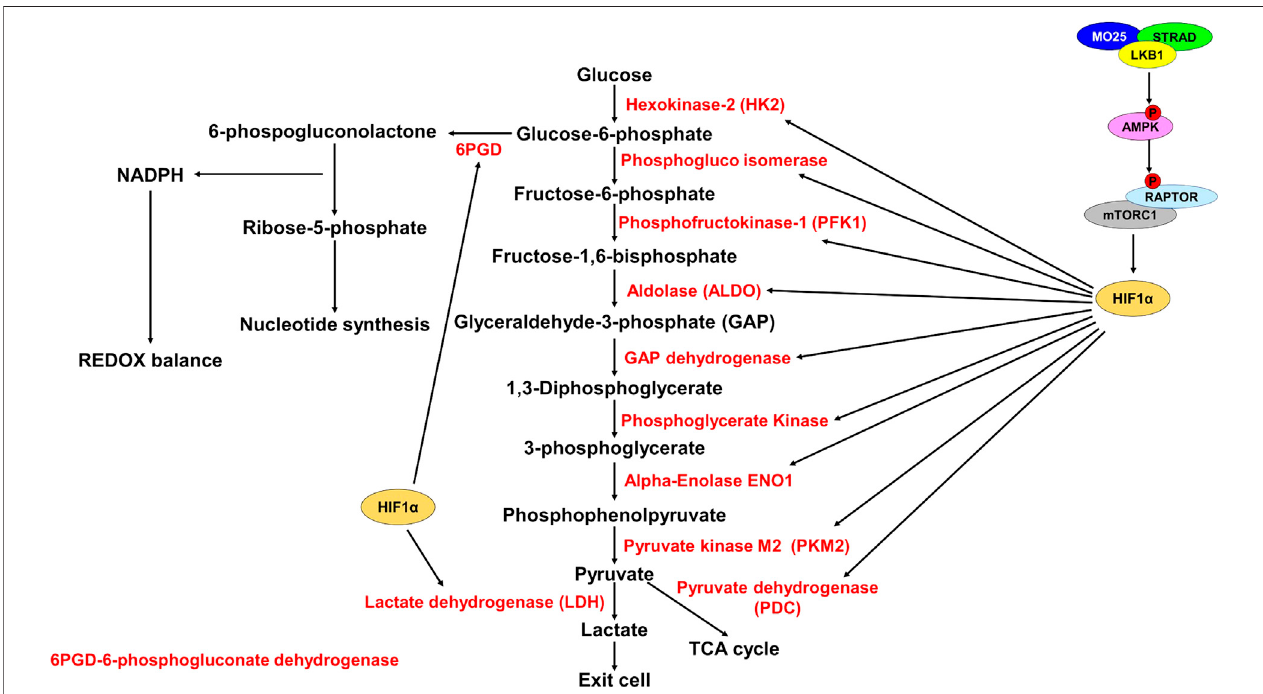
FIGURE 2 | HIF1 α promotes expression of glycolytic enzymes. Schematic representation of glycolysis and the pentose phosphate pathway (PPP). LKB1 phosphorylates and activates AMPK which then phosphorylates and inhibits RAPTOR, thereby inhibiting mTORC1. mTORC1 promotes HIF1 α upregulation. Active HIF1 α promotesexpressionofglycolyticenzymes(red)increasingglycolysisrate.HIF1 α alsopromotesexpressionof6PGDtoshuntglucose-6-phosphatetothePPPto generate NADPH for REDOX balance and for synthesis of ribose-5-phosphate for nucleotide